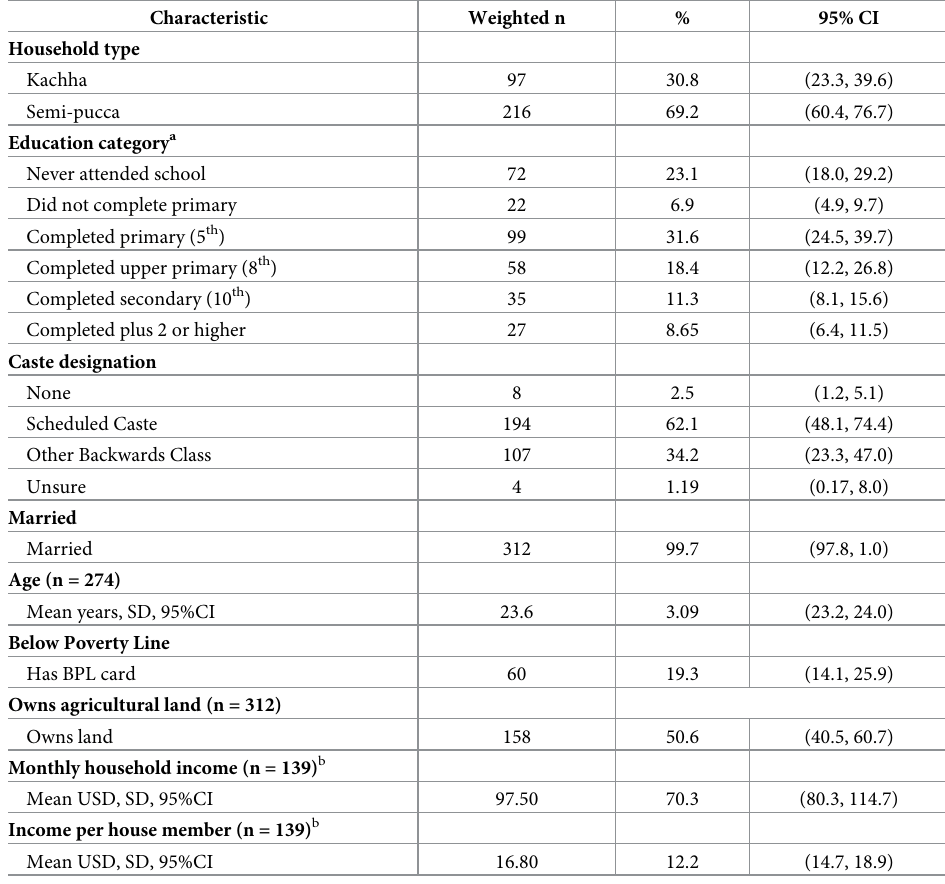
Table 3. Survey population characteristics (n = 313).